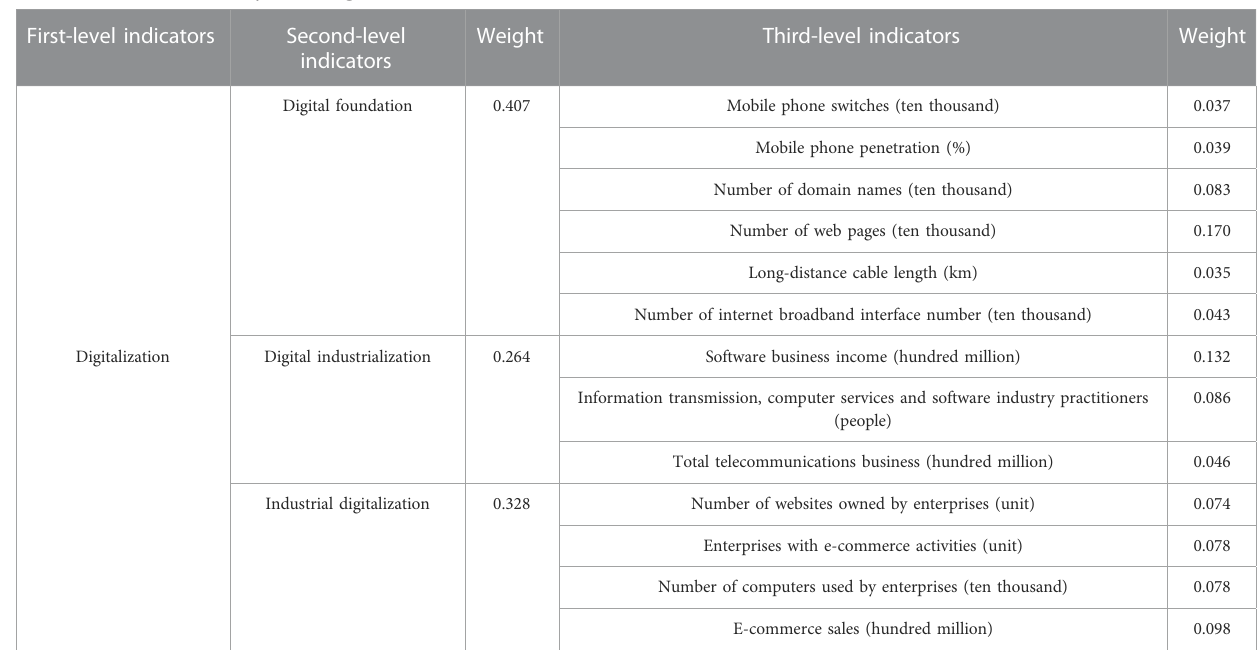
TABLE 2 Measurement index system of digitalization.